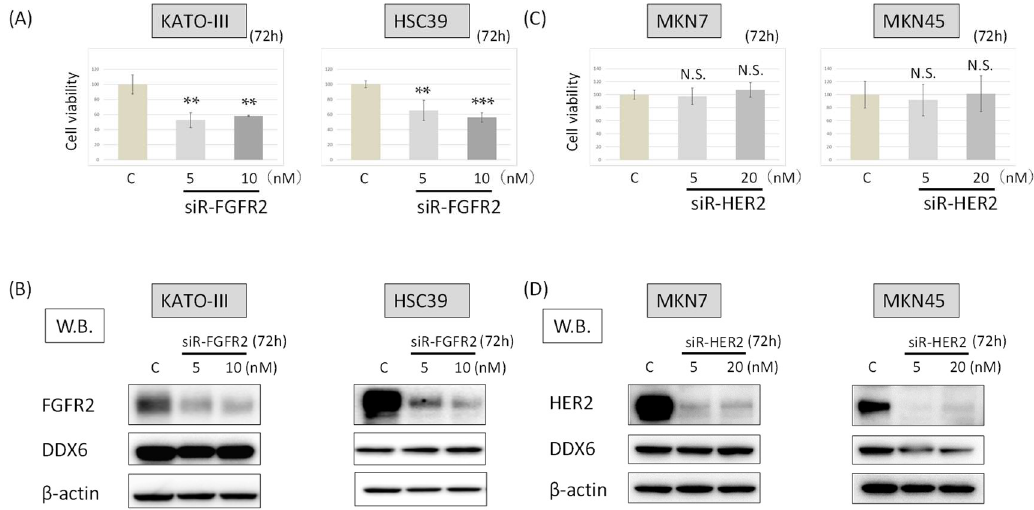
Figure 3. The DDX6 expression after the knockdown of FGFR2 or HER2 . ( A ) Cell viability at 72 h after transfection of KATO-III and HSC39 cells with siR-FGFR2. (control RNA, 10 nM); ( B ) Western blots of FGFR2 and DX6 expression in KATO-III and HSC39 cells at 72 h after transfection with control or siR-FGFR2; ( C ) Cell viability at 72 h after transfection of MKN7 and MKN45 with siR-HER2. (control RNA, 20 nM); ( D ) Western blots of HER2 and DDX6 expression in MKN7 and MKN45 cells at 72 h after transfection with control or siR-HER2. The levels of controls are indicated as “1.” Results are presented as the mean ± SD. ** p < 0.01; *** p < 0.001. N.S., not